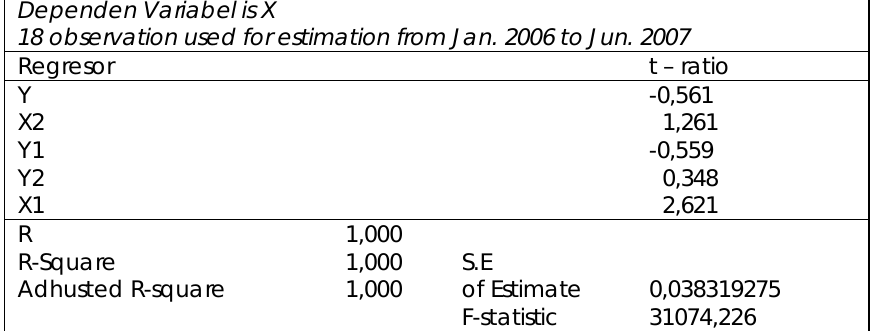
Tabel 2 : Hasil Pengolahan Model 2